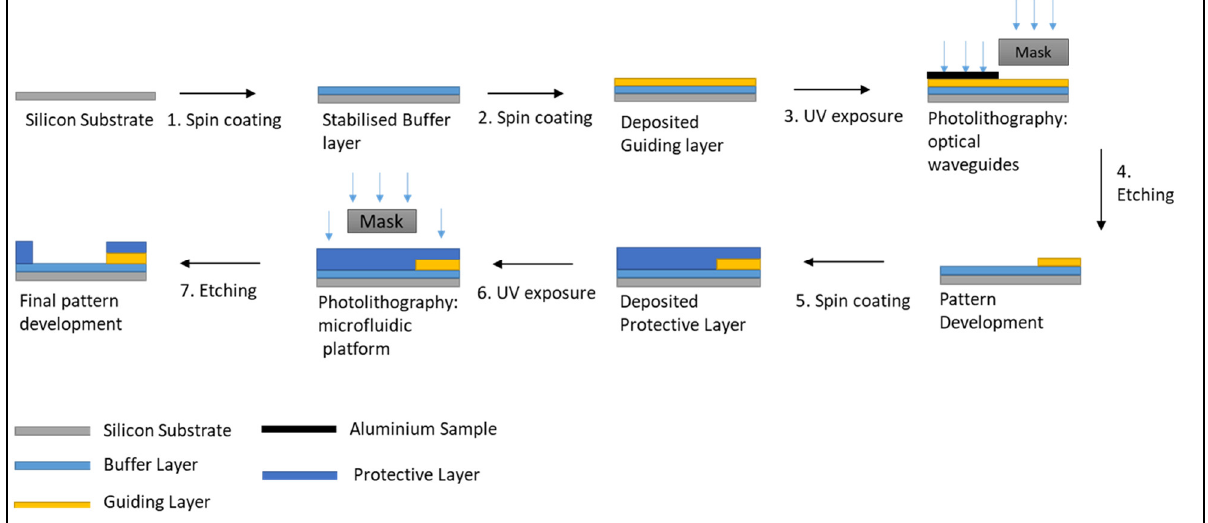
Figure 2. Schematic of the fabrication process for the optofluidic platform.